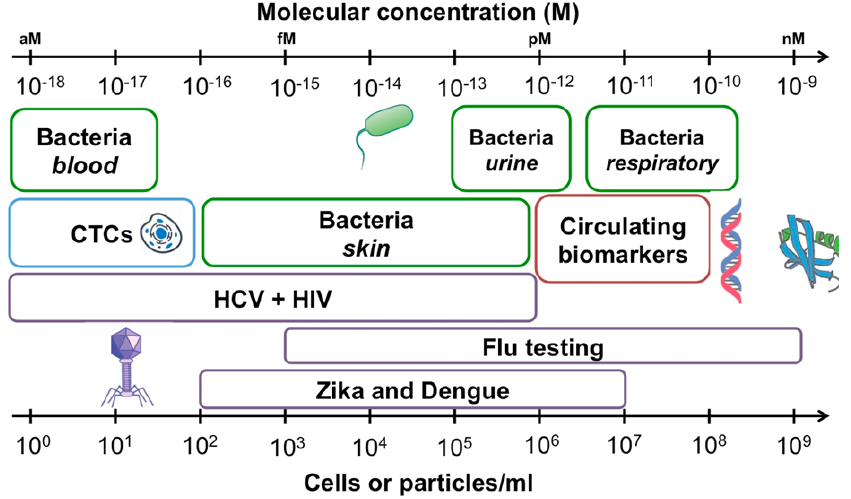
Figure 1. Concentrations of common analytes in biological samples expressed as cells or particles per milliliter of sample (bottom axis), and molarity (top axis). Bacterial concentrations are outlined in green, viral targets are outlined in purple, circulating tumor cells (CTCs) are shown in blue and circulating biomarkers including proteins and nucleic acids in red. Reprinted with permission from Kelley et al. [2] Copyright © 2017 American Chemical Society.